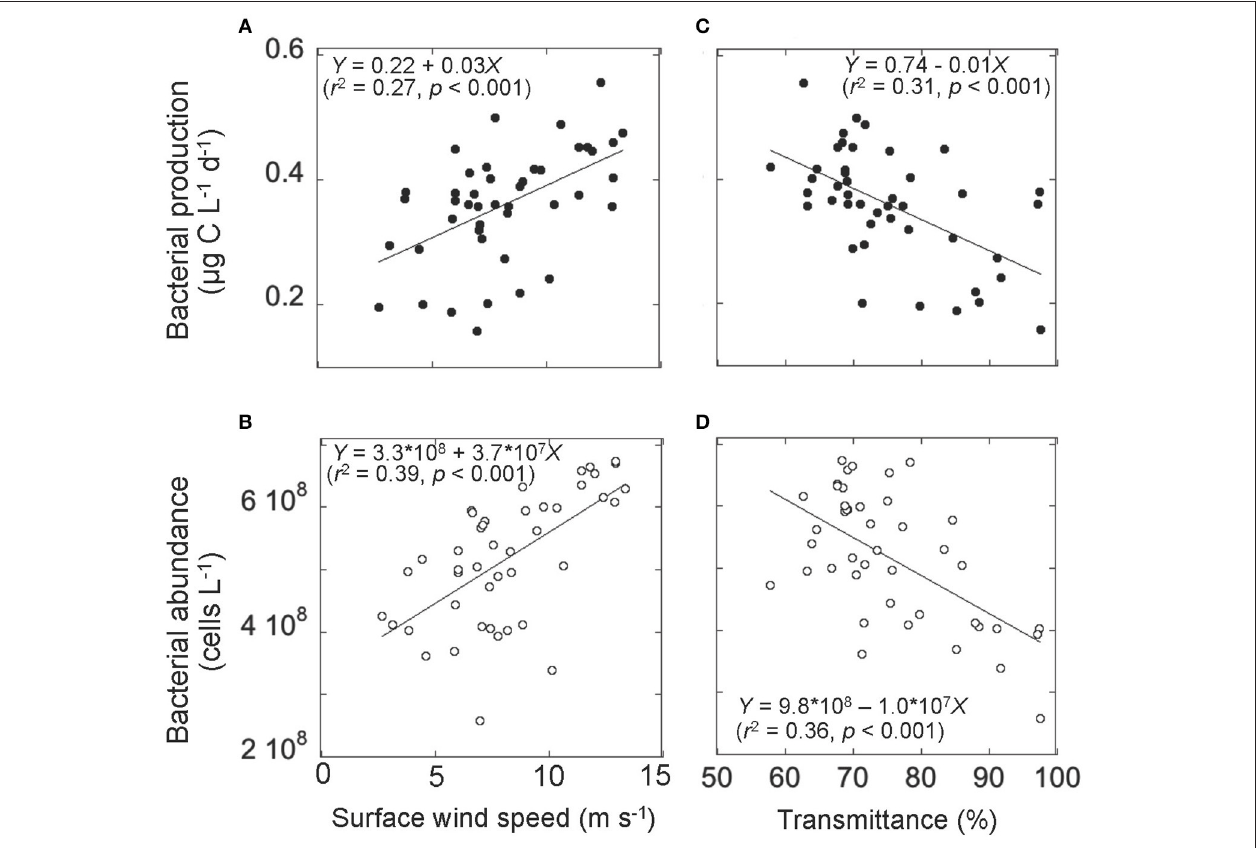
FIGURE 6 | Relationships between (A) surface wind speed and bacterial production, (B) surface wind speed and bacterial abundance, (C) transmittance and bacterial production, and (D) transmittance and bacterial abundance. Data on transmittance and bacterial production and abundance were collected at the water layer 10m above the seafloor. Solid lines represent the Modell II regression line ( Sokal and Rohlf, 1995). The corresponding regression equations with r 2 (coefficient of determination), and p (significance) are also